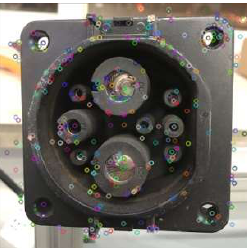
Figure 7. Feature points extracted by SIFT algorithm.